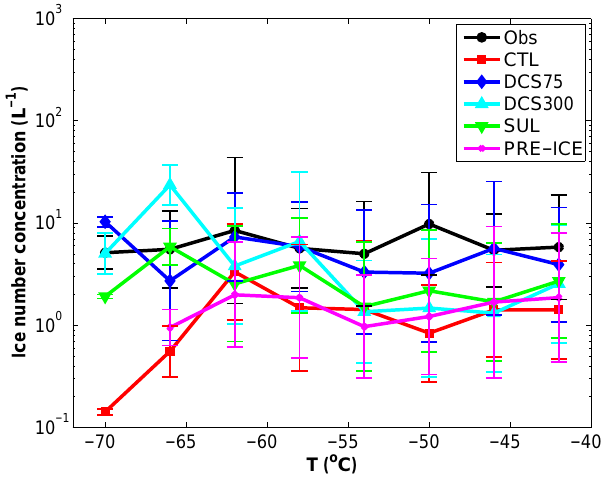
Figure 9. As Fig. 7 but for N i